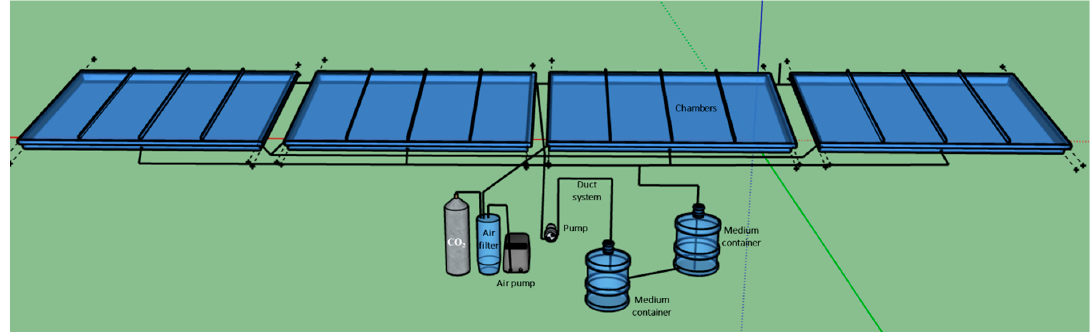
Figure 2. Design of the nutrient and air supply system for the large-scale angled TL-PSBR.